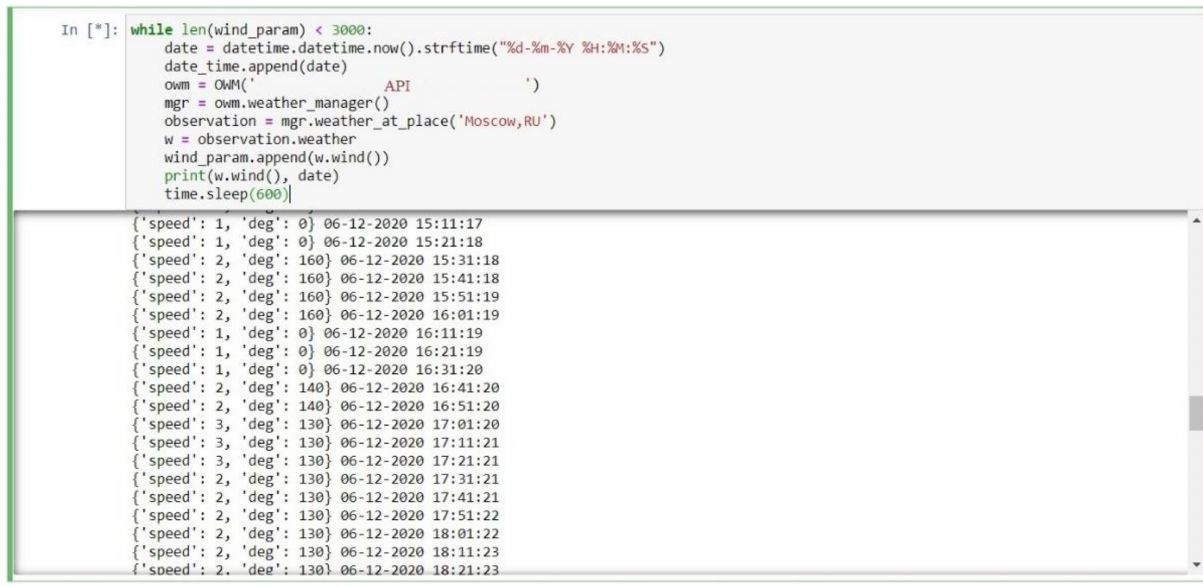
Figure 16. Intermediate program